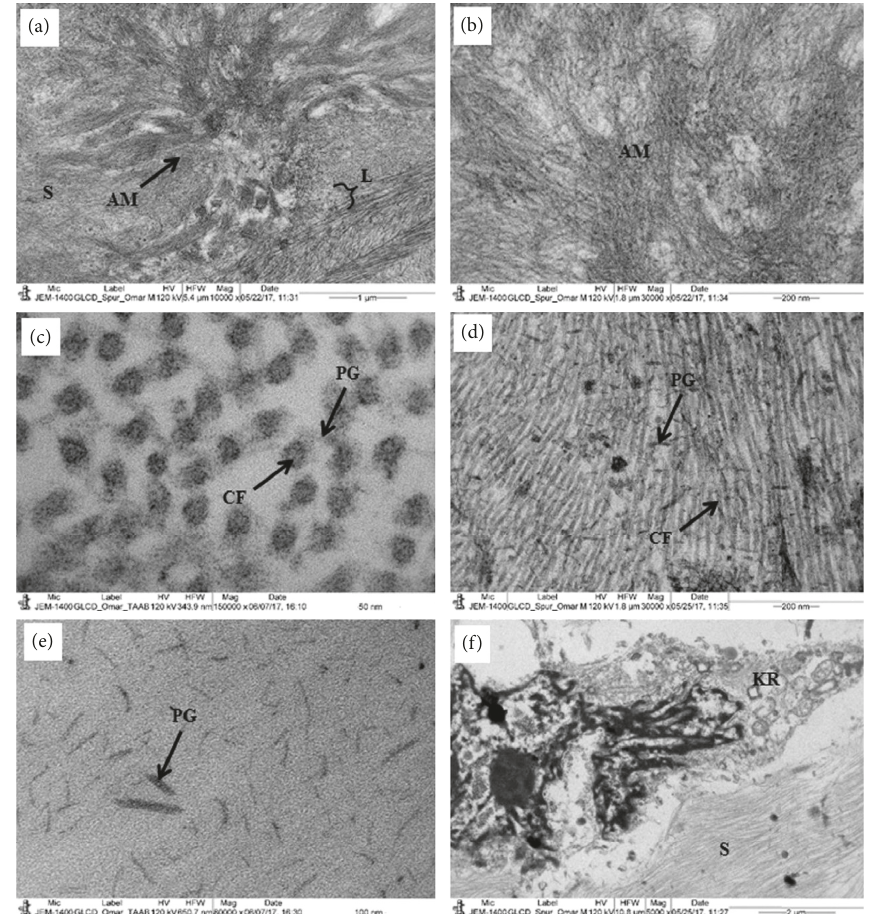
Figure 4: Electron micrograph of the GDLD cornea. (a) A whorl-like structure of the amyloid deposit containing very thin amyloid fibrils. (b) The electron-dense and electron-lucent amyloid fibril in the deposit. (c) Part of the stroma showing cross section of randomly distributed collagen fibrils; (d) part of the stroma showing randomly longitudinally running collagen fibrils with large proteoglycans; (e) part of the stroma showing very large proteoglycans (no staining of Ua and Pb); (f) part of the stroma showing a degenerated keratocyte containing large apoptotic nucleus. AM: amyloid deposits; CF: collagen fibrils; KR: keratocyte L: lamella; PG: proteoglycans; S: